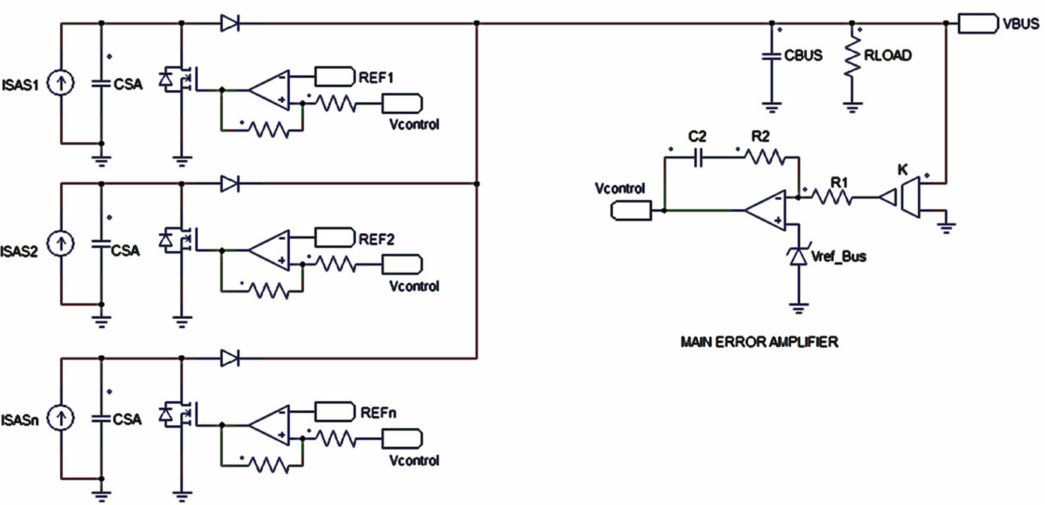
Figure 2. Sequential switching shunt regulator ( S 3 R ) simplified